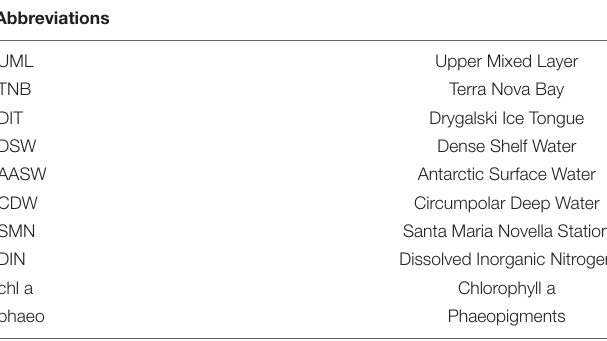
TABLE 1 | Abbreviations used in the text.